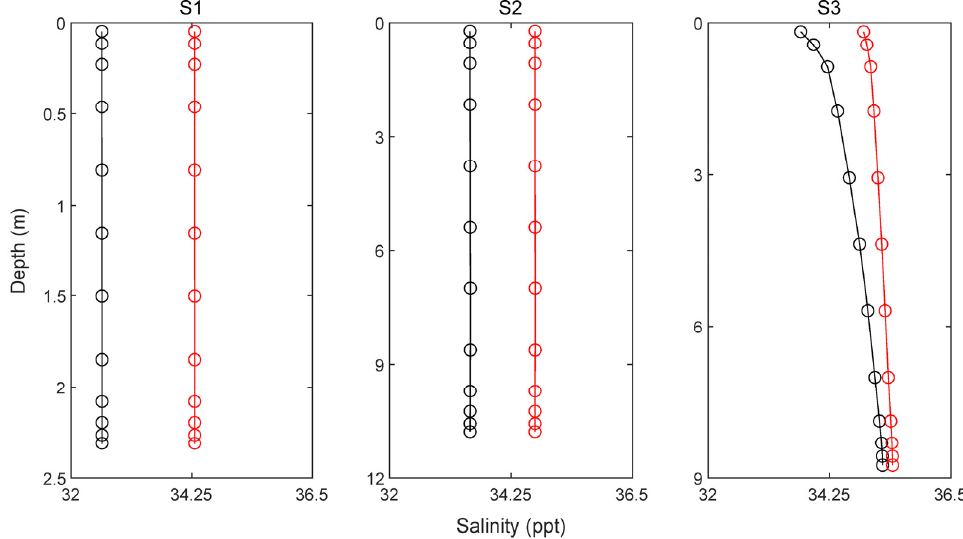
Figure 6. Salinity vertical profiles at S1, S2, and S3 during CS1 (spring–summer season) (red line) and CS2 (autumn–winter season) (black line).